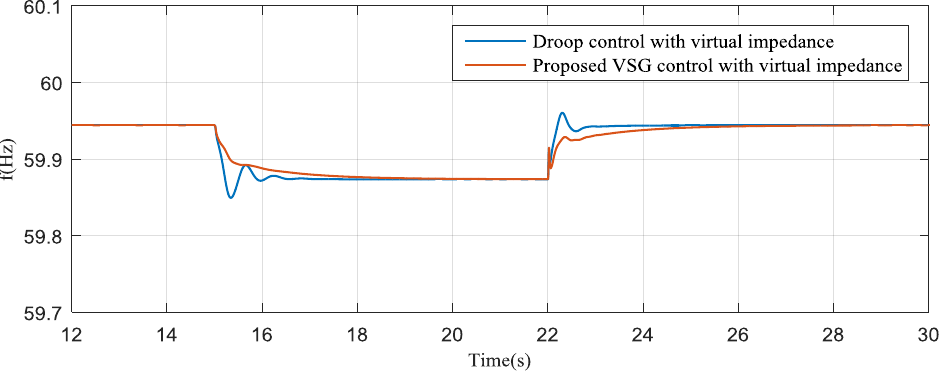
Figure 26. System frequency.